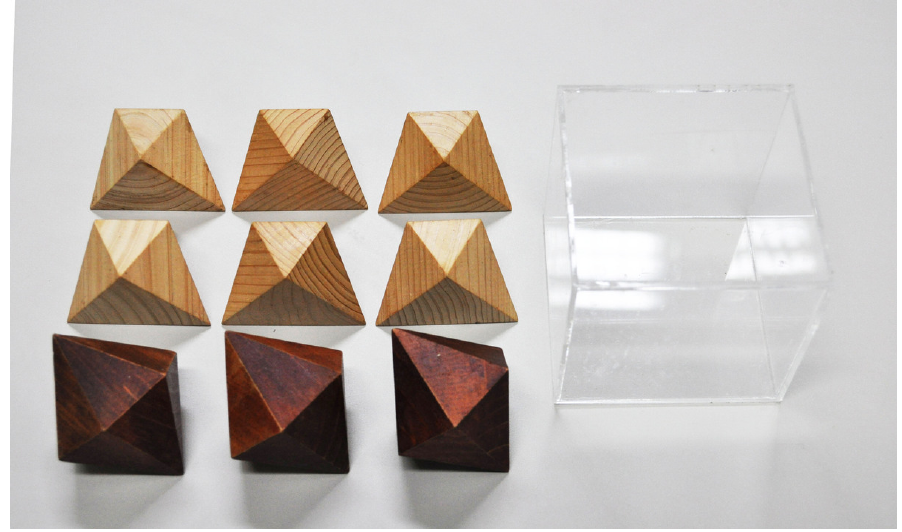
Figure 4. The nine pieces and the box that make up the imaginary cube puzzle 3H =